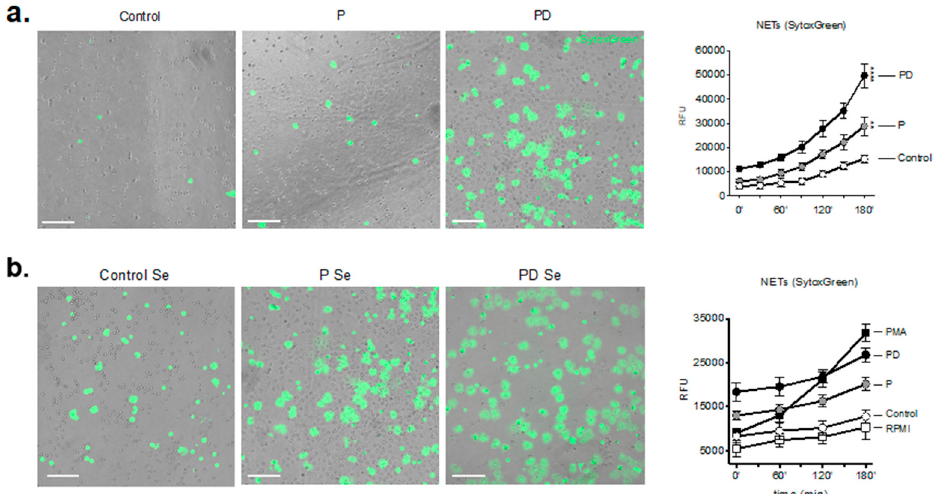
Figure 2. Neutrophil pro-NETotic activity is augmented 48 h post-delivery. ( a ) Detection of in vitro spontaneous NET formation of neutrophils from healthy controls, donors during pregnancy and postpartum release in a 3 h time course by fluorescence microscopy using dsDNA-binding fluorescent SytoxGreen dye and fluorimetry (right panel). ( b ) In vitro spontaneous extracellular DNA release monitored in a 3 h time course by SytoxGreen dye microscopy after treatment of control neutrophils with pregnancy and post-delivery serum and fluorimetric quantification (right panel). Magnification: 10 × . Scale bars: 100 µ m. P: pregnancy; PD: post-delivery; ecROS: extracellular ROS; icROS: intracellular ROS; RFU: relative fluorescence units; MLU: mean fluorescence units; AUC: area under the curve. Data are presented as mean ± SEM. ** p < 0.01, **** p < 0.0001 (one- or two-way anova followed by bonferroni’s multiple comparison post-test). all experiments were performed at least 3 times with consistent